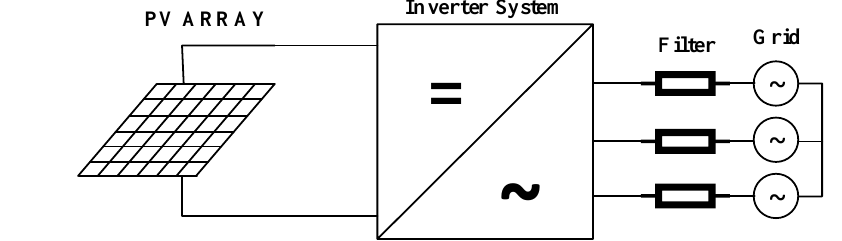
Figure 1. Principle structure of photovoltaic